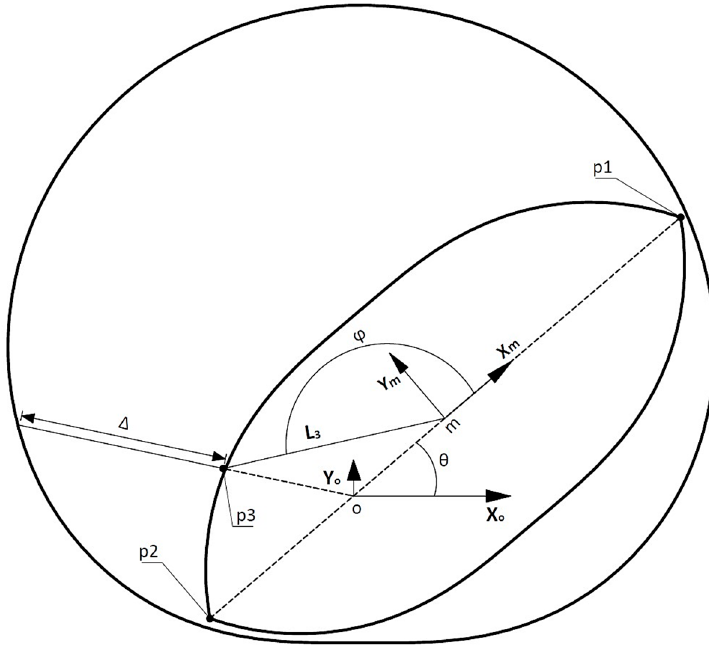
Figure 2. The rotor-housing clearance.